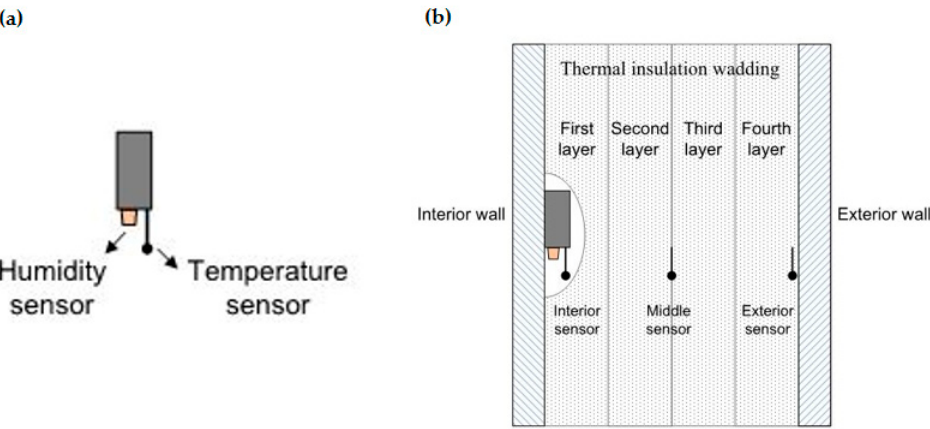
Figure 12. ( a ) Humidity and temperature sensor configuration ( b ) sensors’ distribution between thermal insulation layers.